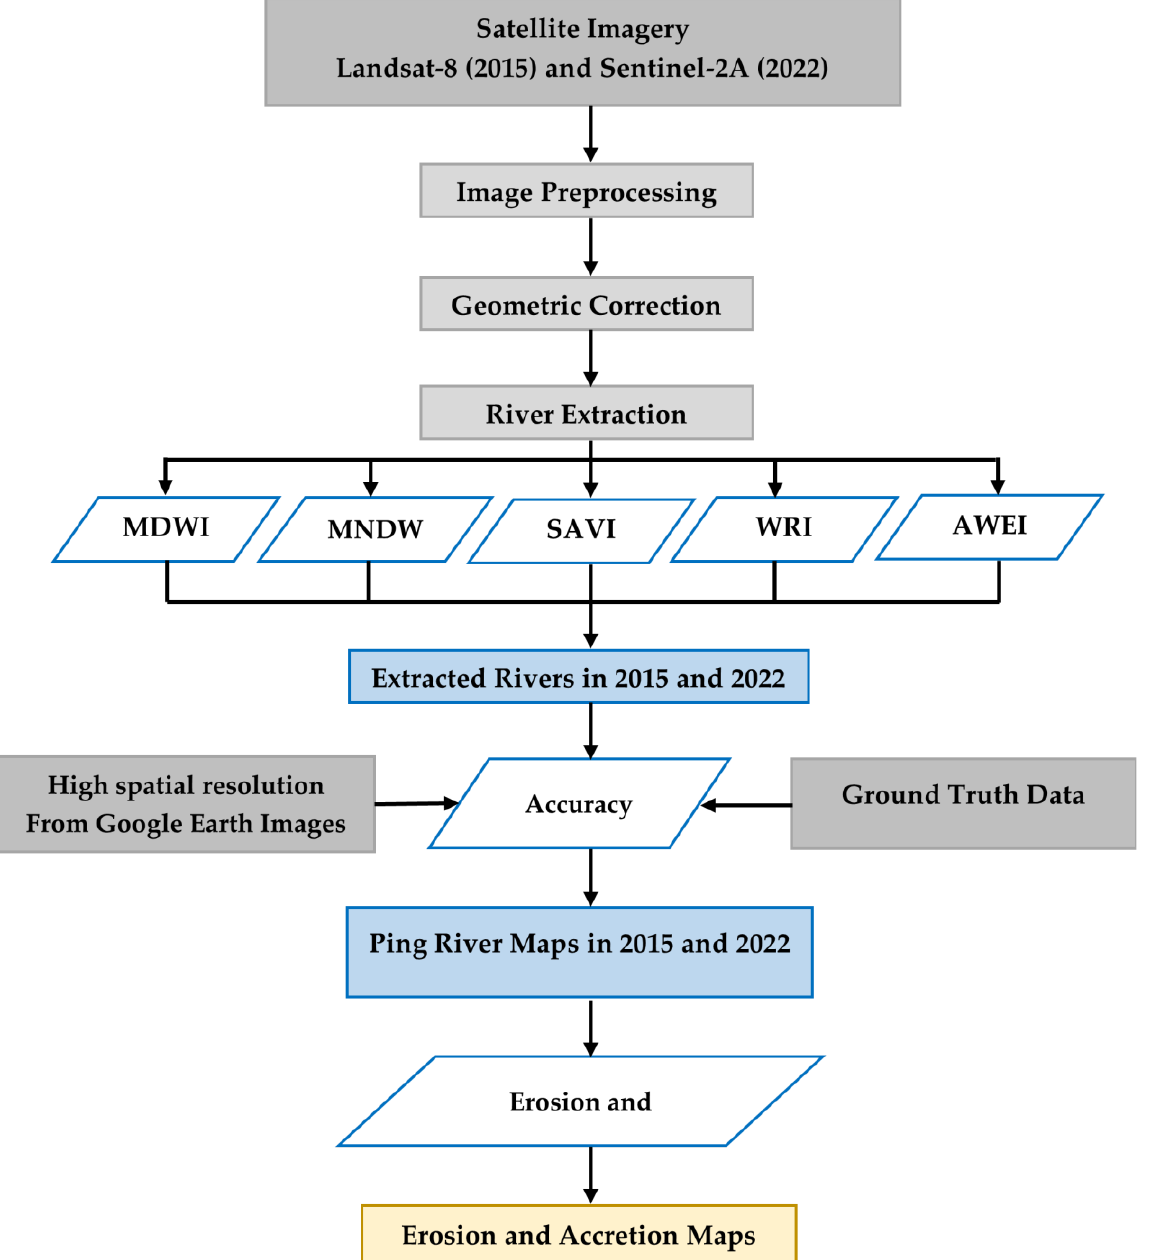
Figure 4. The flowchart of the method for extraction of the Ping River from satellite